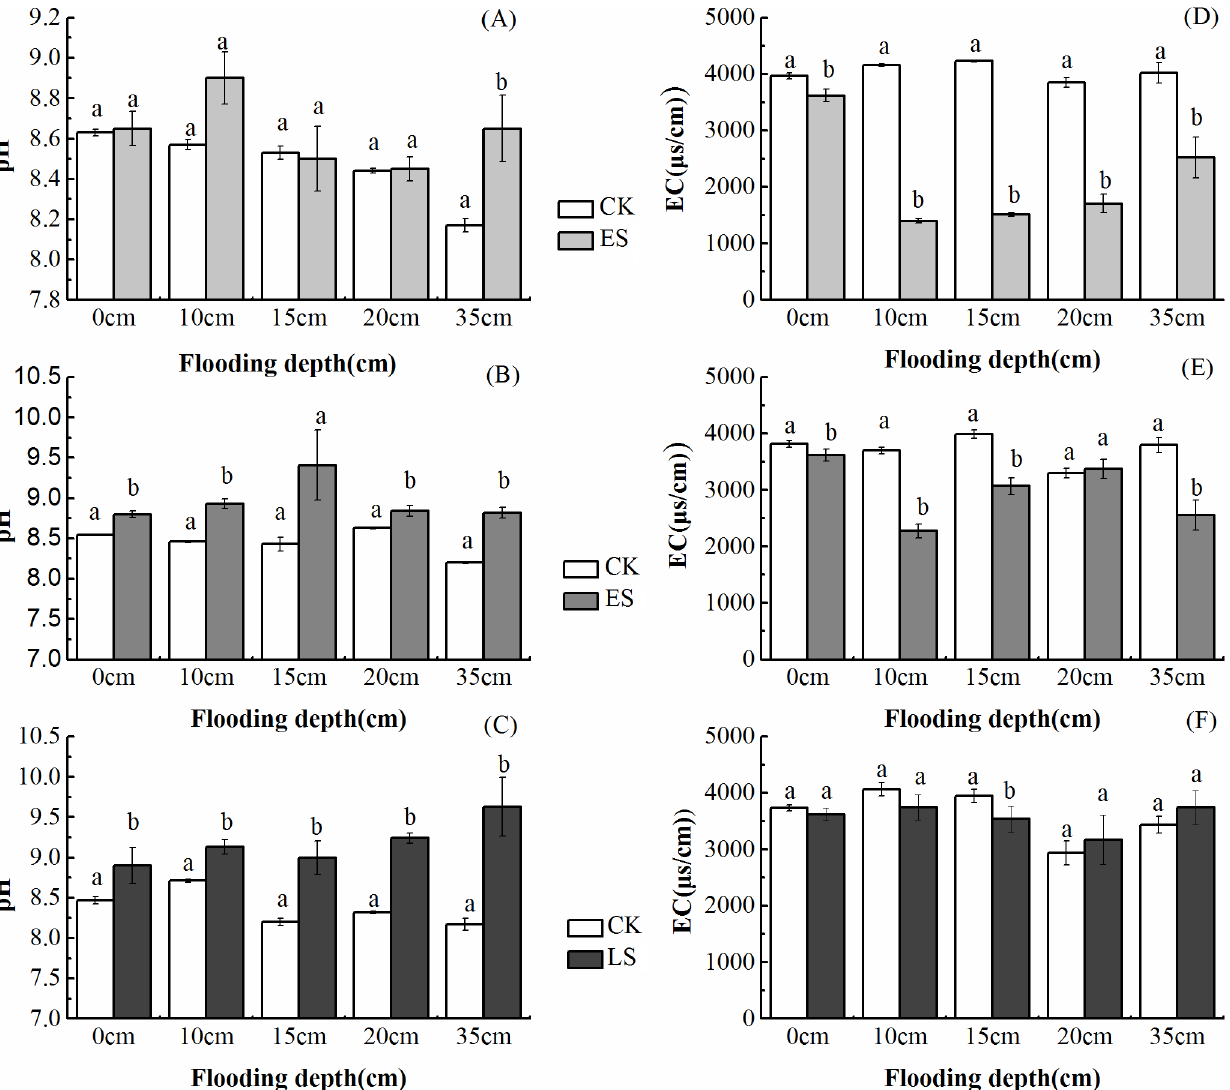
Fig 4. pH and electricalconductivity(EC) subjectedto different water supplement regimes: A-C is pH at early stage, middlestage and later stage; D-F is electricalconductivity(EC) at early stage, middle stage and later stage. Different lower-caseletters indicateddifferencesin pH and